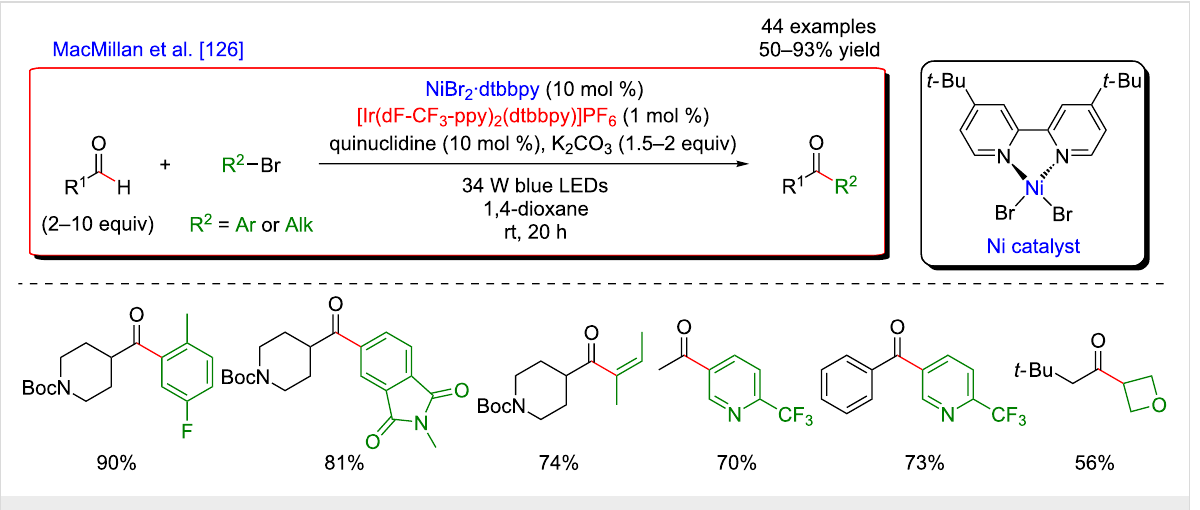
Figure 75: Aldehyde C–H functionalization promoted by H-atom